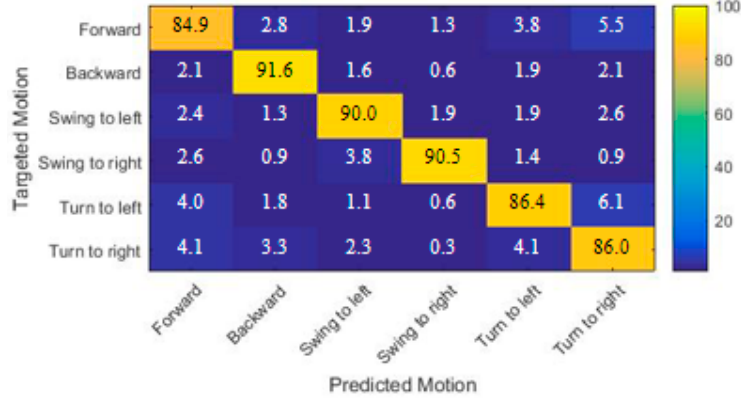
Figure 7. The confusion matrix of the classification (feature set (2 + 3 + 5), radial basis function).